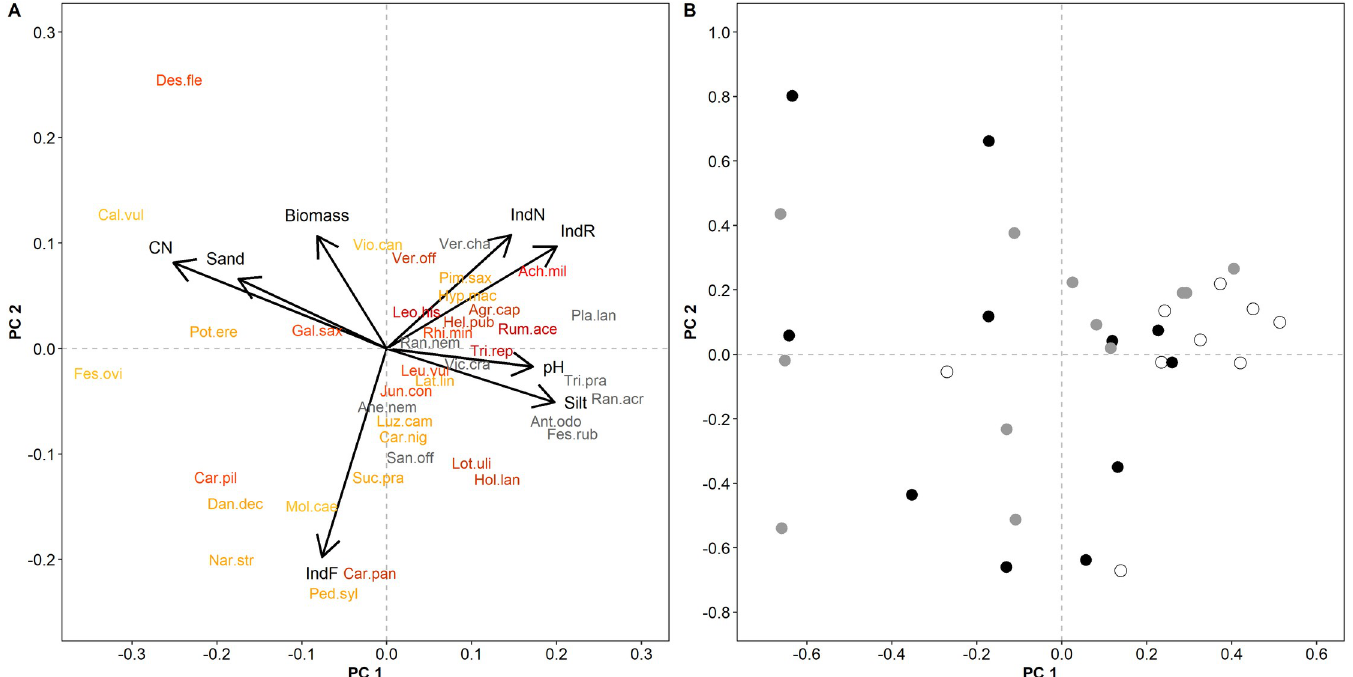
Fig 4. PCA results for plant species composition. (A) Species-environment biplot. First two components explained 33.3% of variance (22.5%, 10.8%). Abiotic and biotic variables that were significantly related to the PCA axes (p < 0.05, based on a permutation test with 10,000 permutations) were included post-hoc by projection. For clarity, only the 40 most frequent species are shown. Species names are colored according to their Ellenberg indicator N values from shades of red (N values of 5–6) to orange (3–4) and yellow (1–2) hues. For gray colored species names, no assigned indicator values were available. Abbreviations of parameter names are used according to Fig 2. (B) Scatter diagram with sample scores for the extinct (white), small (gray), and large (black) population sites.